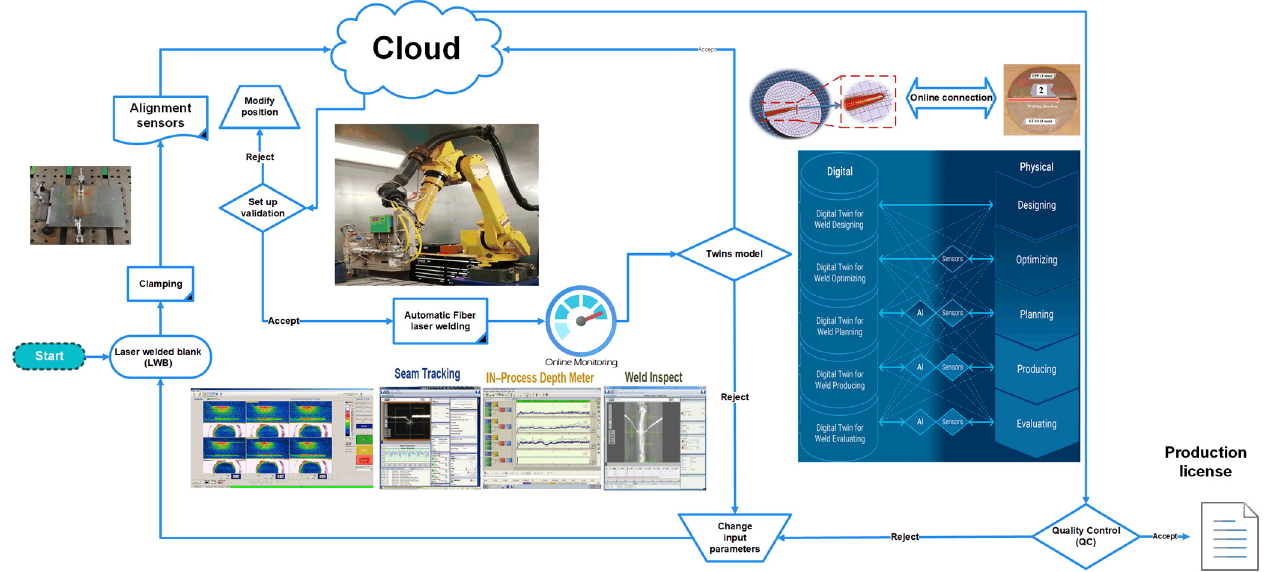
Figure 4. Digital twins model for Inspection 4.0 of laser-welded blanks.